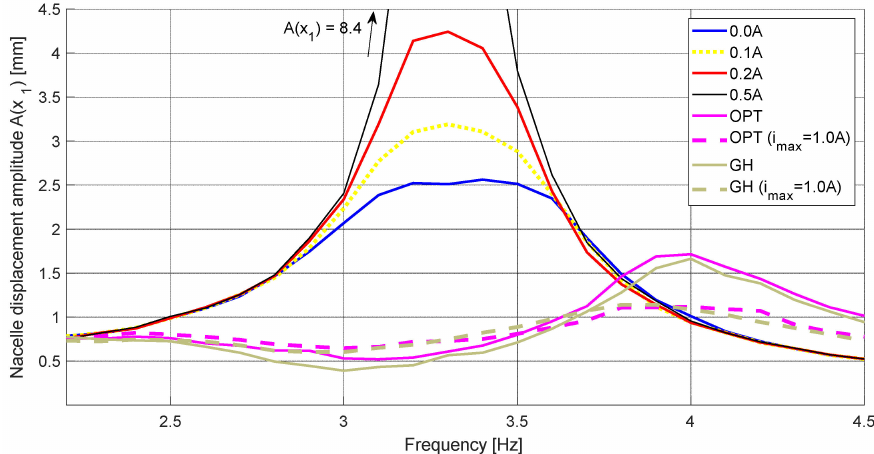
Figure 6. Nacelle horizontal displacement amplitude A ( x 1 ) frequency characteristics: passive system vs. OPT for F nom = 12.5 N vs. GH for F nom = 12.5 N.